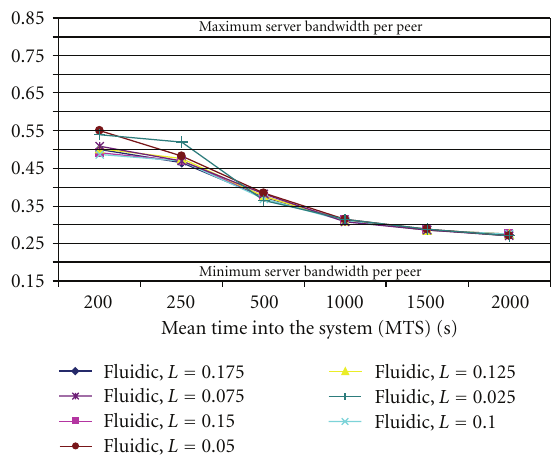
Figure 8: Mean server bandwidth requested by each peer in the Fluidic model with di ff erent peer input rates.